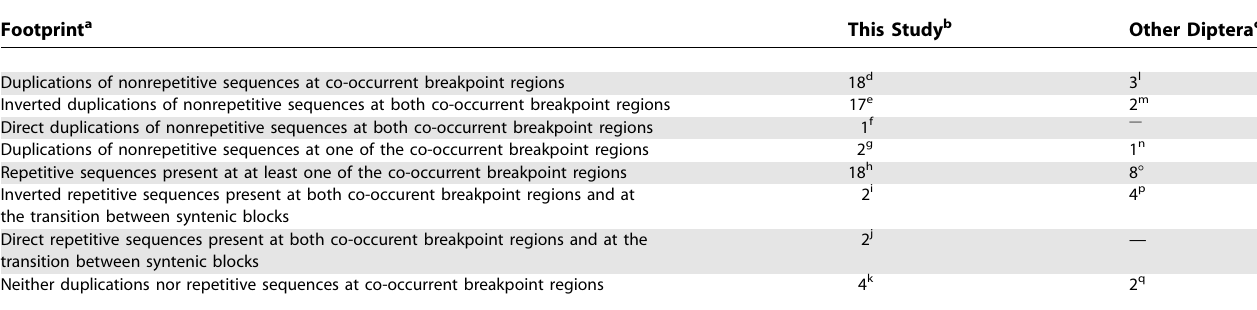
Table 3. Presence of Duplications and Repetitive Sequences at Breakpoint Regions of Characterized Dipteran Inversions Footprint